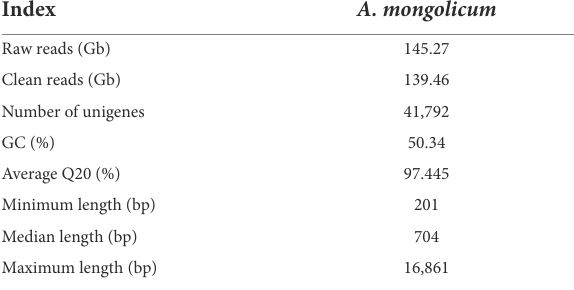
TABLE 2 Summary of transcriptome sequencing for Agropyron